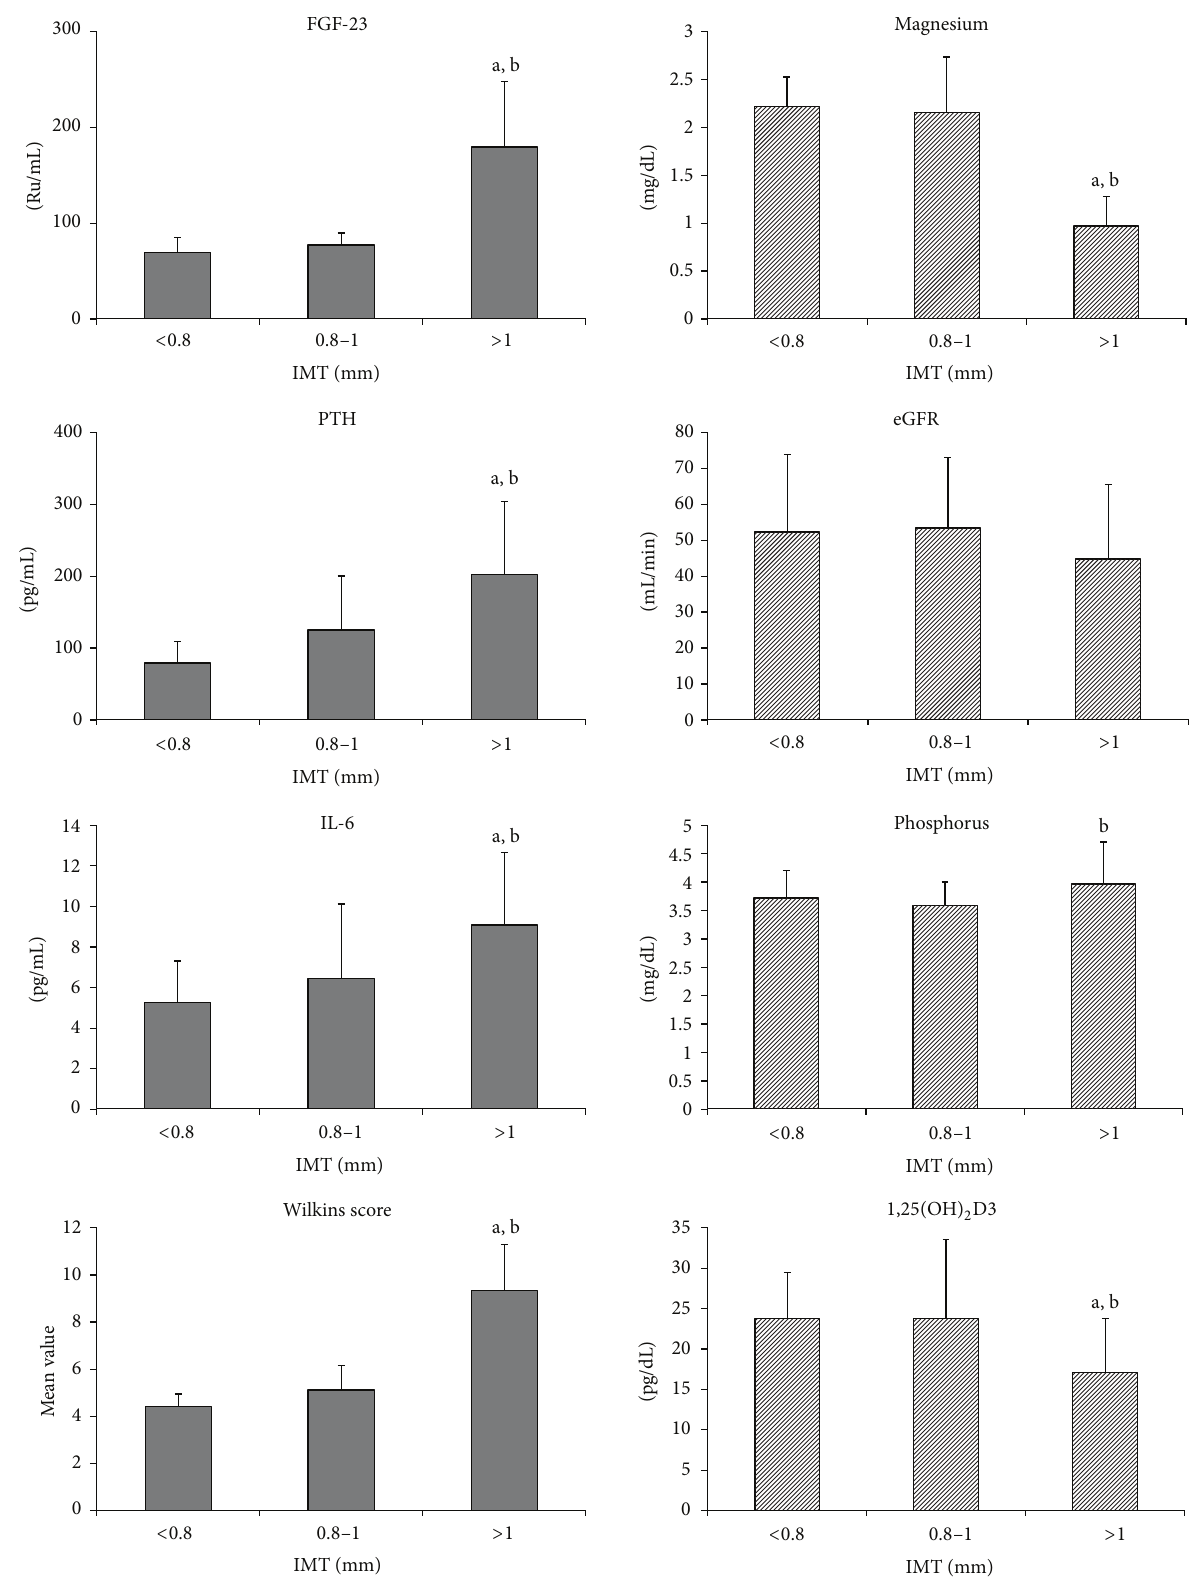
Figure 3: Parameters according to IMT values, < 0.8mm ( 𝑛 = 25 ), 0.8–1mm ( 𝑛 = 69 ), and > 1mm ( 𝑛 = 56 ). Results of post hoc analysis: a— 𝑃 < 0.05 versus Group 1 and b— 𝑃 < 0.05 versus Group